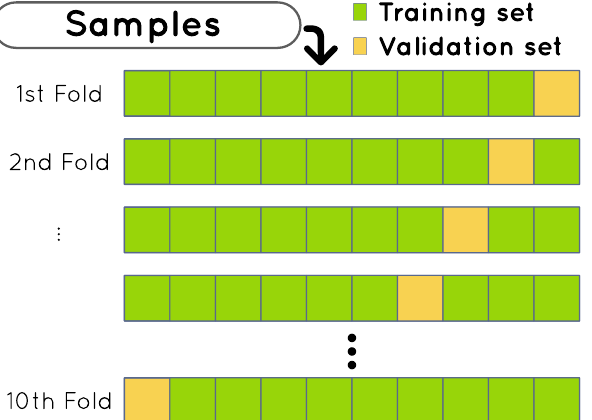
Figure 4. Splitting the dataset generates 10 folds, giving a chance to all samples that are part of the validation once. We notice that this is a type of bagging ensemble because each fold trains a model and then the results of each trained mode are